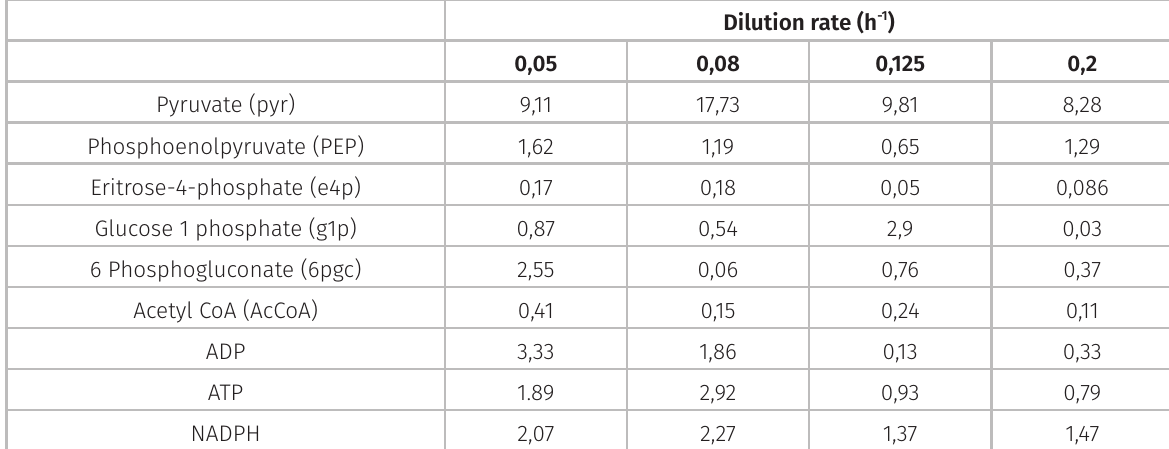
Table II. Intracellular metabolite concentration for Lacticaseibacillus paracasei at different dilution